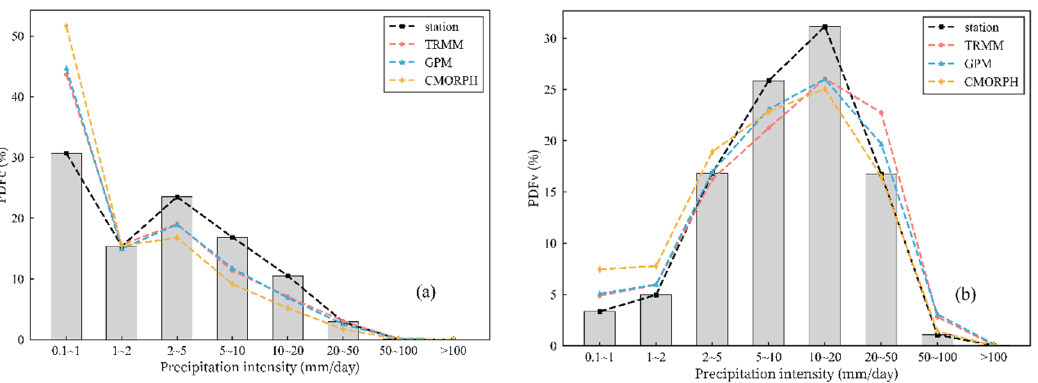
Figure 9. Probability distribution function by ( a ) occurrence and probability distribution function by ( b ) volume for three remote sensing precipitation products and ground stations.